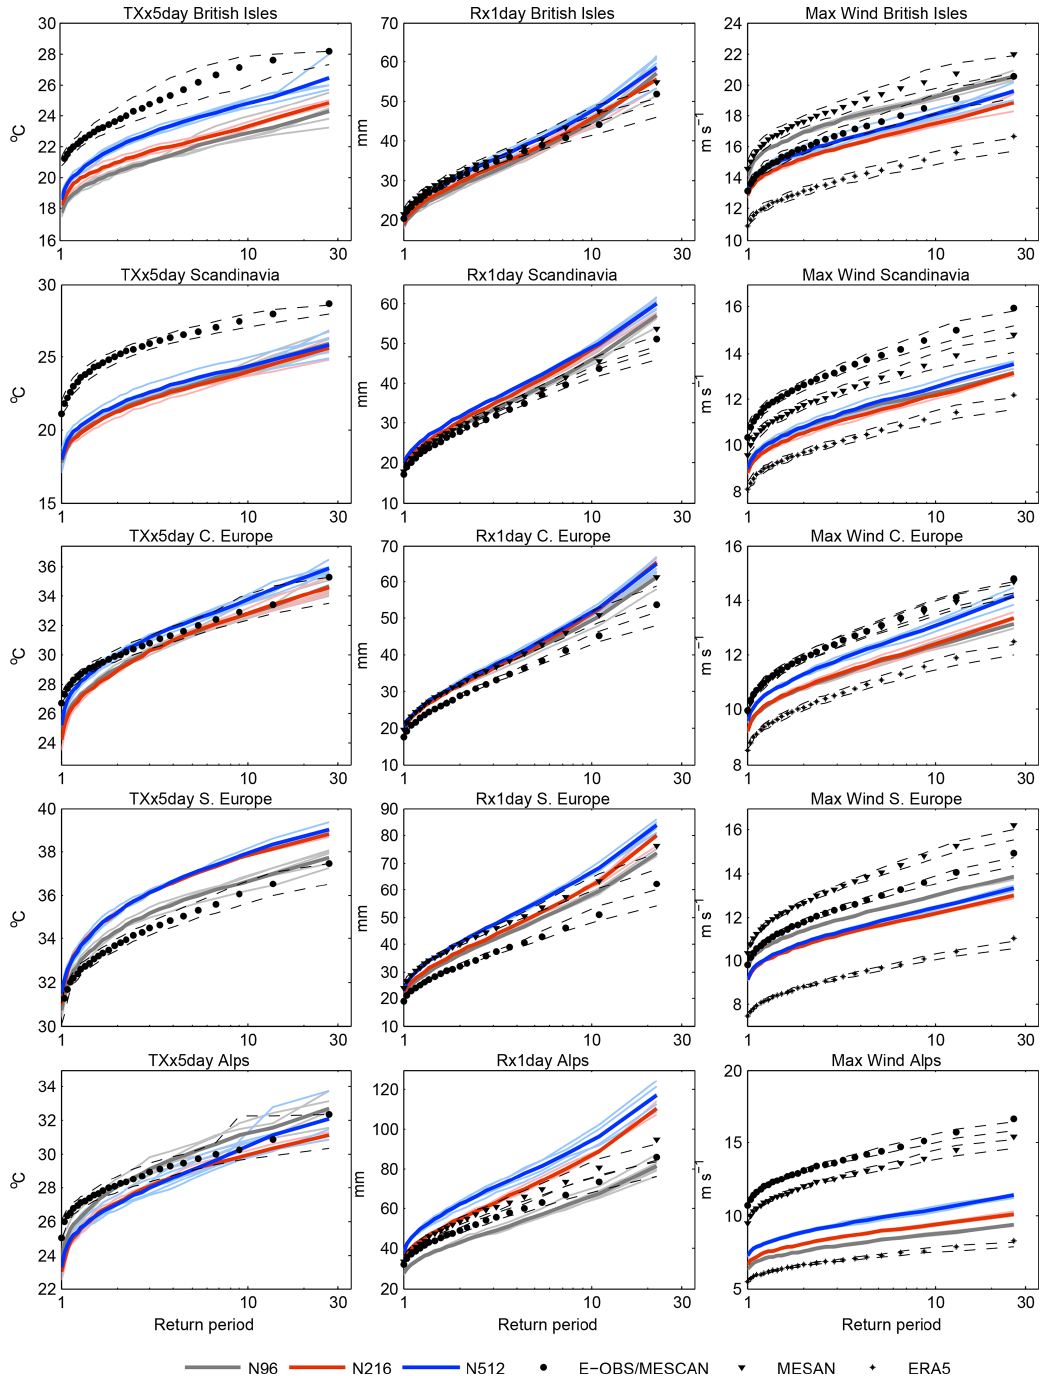
Figure 6. Return period plots for (left) TXx5day; the middle column represents Rx1day and (right) annual maximum wind for the UPSCALE simulations for (top row) the British Isles, (second row) Scandinavia, (third row) central Europe, (fourth row) southern Europe, and (last row) the Alps. N96 is shown in grey, N216 in red, and N512 in blue. Thin lines are individual ensemble members, and thick lines represent ensemble means. Observational datasets are shown in black, circles are for E-OBS and MESCAN, triangles are for MESAN and DYNAD, and asterisks are for ERA5. Confidence intervals based on bootstrapping are shown with dashed lines for the observational datasets. The time periods considered are 1985–2011 for TXx5day, 1989–2010 for Rx1day, and 1986–2011 for wind. In contrast to Fig. 2 the curves have not been shifted to have the same mean value (see Methods); see Fig. S10 for the shifted